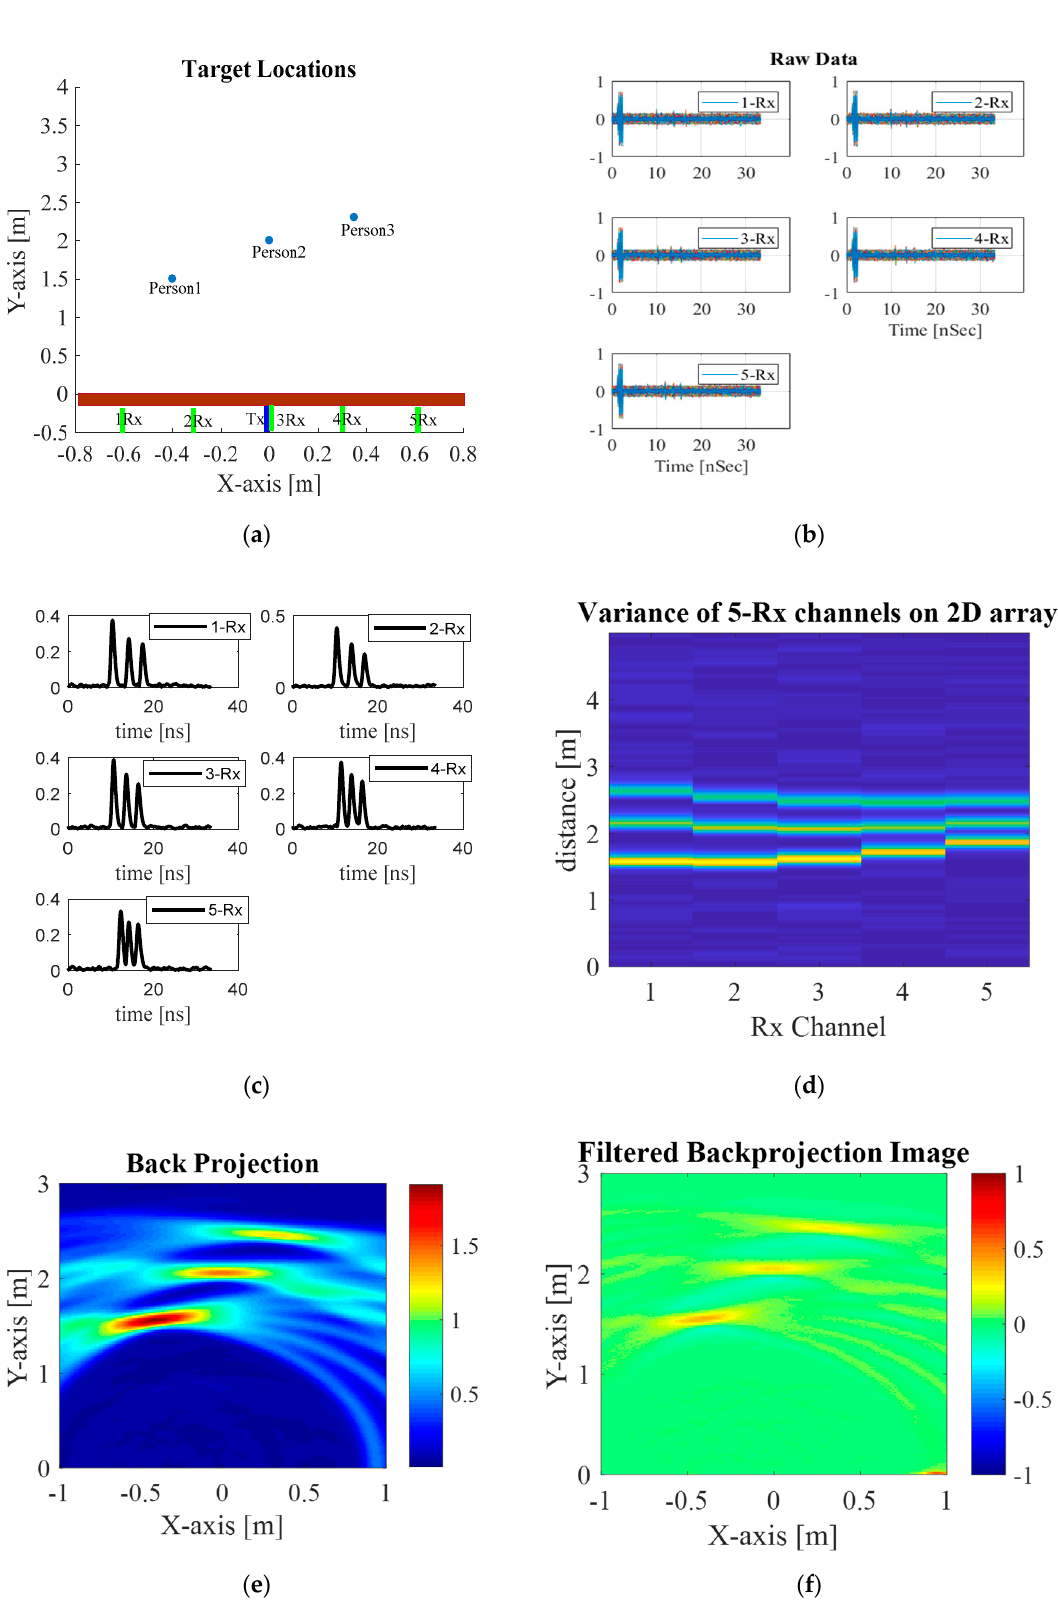
Figure 7. Simulation conditions and results: ( a ) three stationary human subjects behind the wall, ( b ) simulated received signals carrying vital signs of three human subjects, ( c ) statistical variance analysis of each channel, ( d ) statistical variance analysis of each channel on 2D data, ( e ) radar imaging by back projection, ( f ) refined radar imaging using Sinc-filtered back projection, given − 1 < x < 1 and 0 < y < 3.